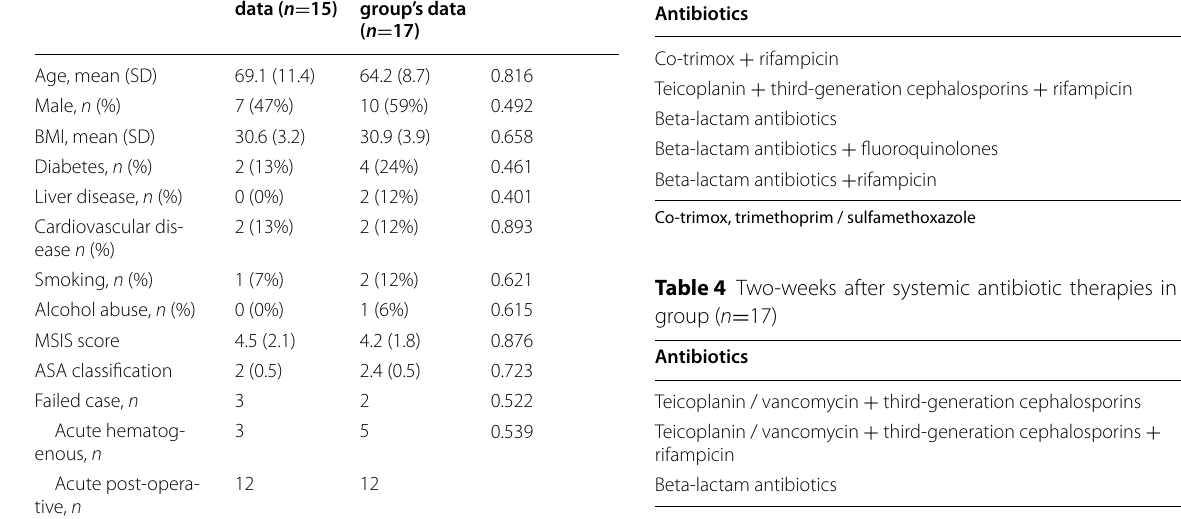
DAIR debridement, antibiotics, and implant retention, DABRI debridement antibiotic pearls and retention of the implant, n.s. not significant, SD standard deviation, ASA American Society of Anesthesiologists classification, PJI periprosthetic joint infection, MSIS Musculoskeletal Infection Society.